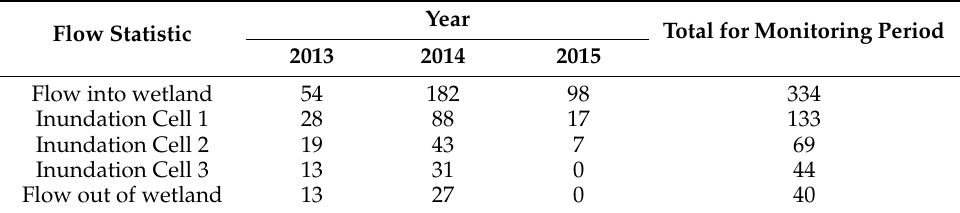
Table 4. Approximate number of days of inundation observed in each wetland cell. This was defined as the number of days water was covering the entire cell and reached the control structure leading out of the cell.